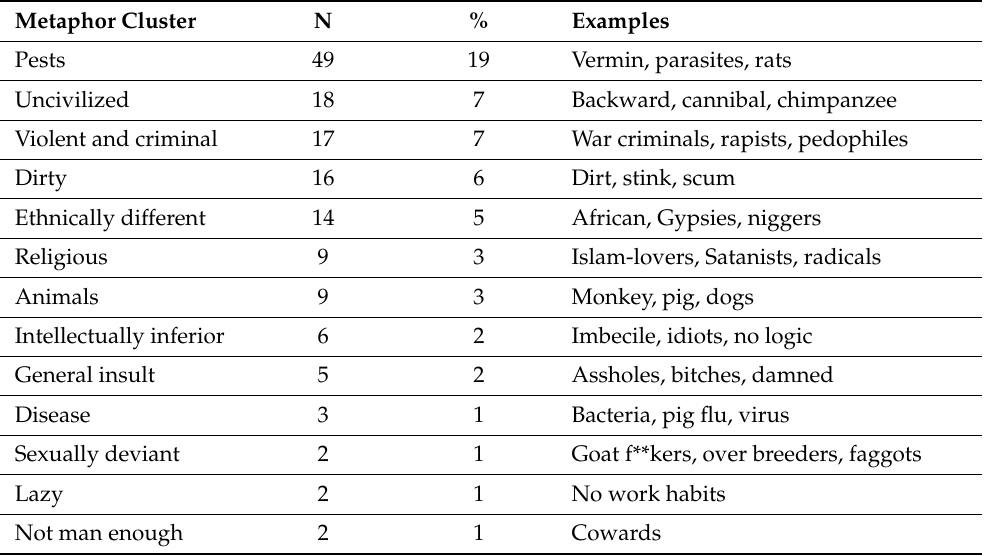
Table 5. Metaphors: clusters, numbers, shares, and examples of statements (N =